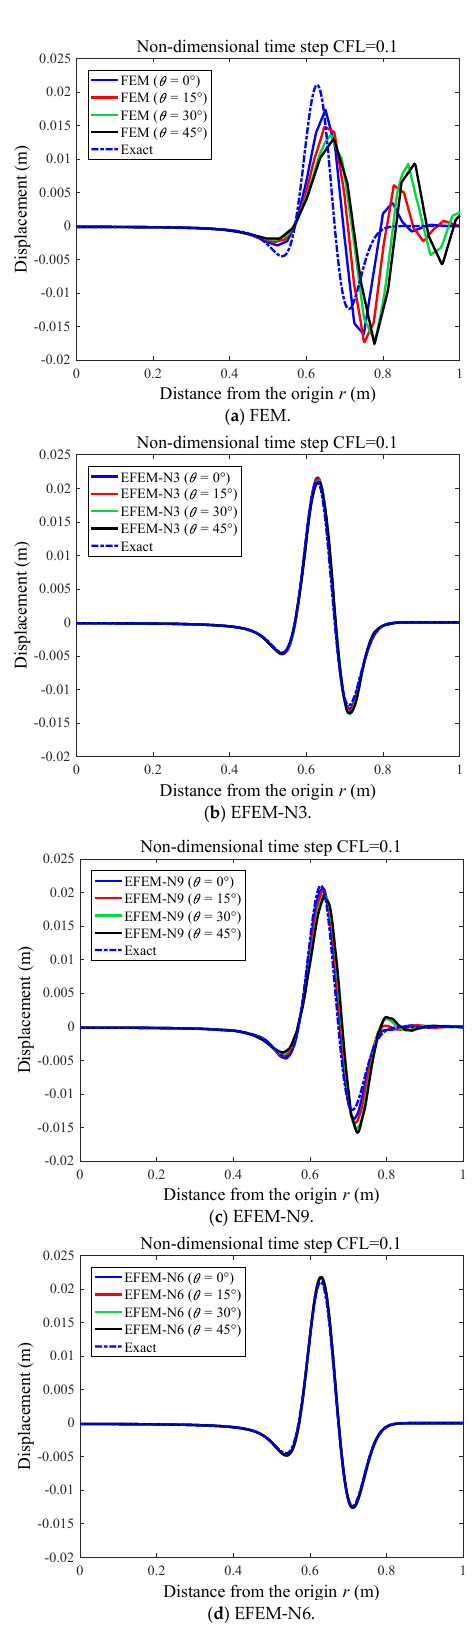
Figure 8. The displacement responses of the square membrane from various numerical techniques by varying the considered angles of wave travel.